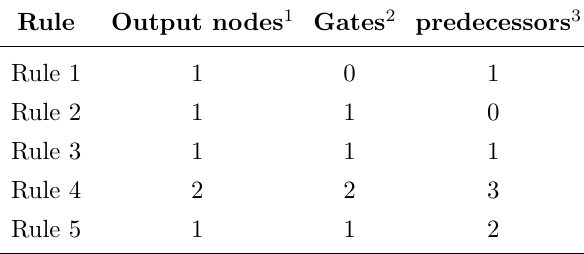
Table 4: The costs of